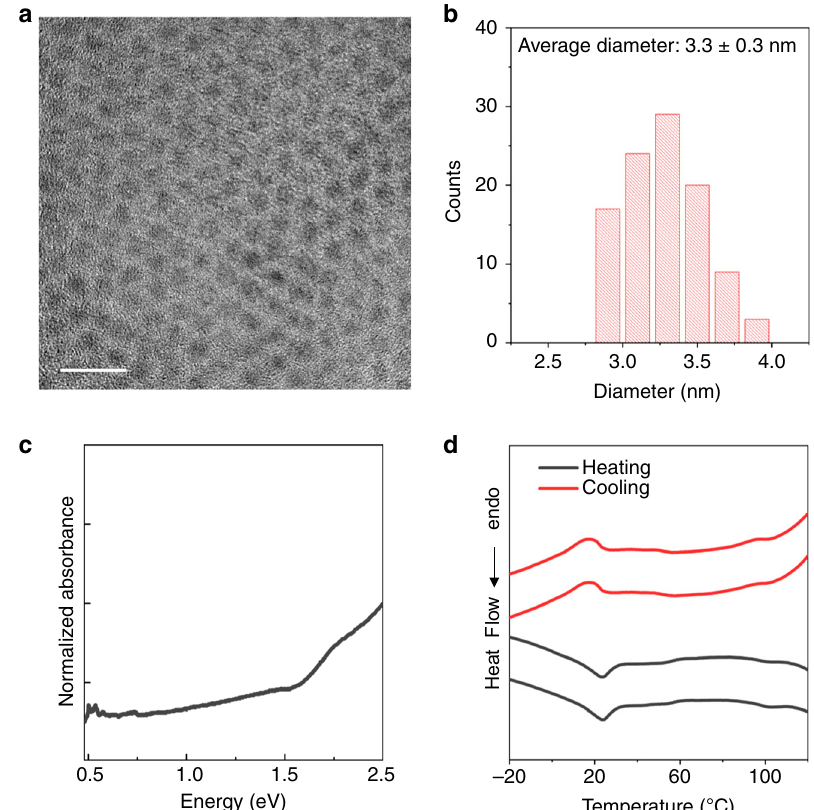
Fig. 9 Characteristics of Cu 2 − x S NCs of a smaller size. a Representative TEM image (scale bar = 10 nm) of Cu 2 − x S NCs of a smaller diameter prepared with no air-injection and b histogram showing the NC diameter distribution determined by ImageJ analysis of the TEM image. The average diameter of the NCs is determined to be 3.3 nm with a standard deviation of 0.3 nm. c Vis – NIR extinction spectrum (normalized to 1 at 2 eV) of the Cu 2 − x S NCs of 3.3 nm average diameter. The NCs synthesized with no air-injection are expected to have a stoichiometry of Cu 1.97 S analogous to the case of ca. 7 nm diameter NCs, however the LSPR absorption of these smaller NCs was too weak to assign an ω sp . It is possible the NCs are nearly Cu 2 S in stoichiometry. d DSC thermograms of the these NCs. Thermograms from two heating – cooling cycles performed on the same sample of NCs are shown, from which the reproducibility of the phase-transition peaks (dips) is evident. The peak temperature of the phase-transition in the heating sub-cycle was averaged over the two cycles to yield a T c of 24 °C with a standard deviation of 0.3